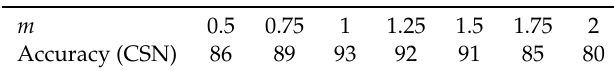
Table 1. Choosing the value of m